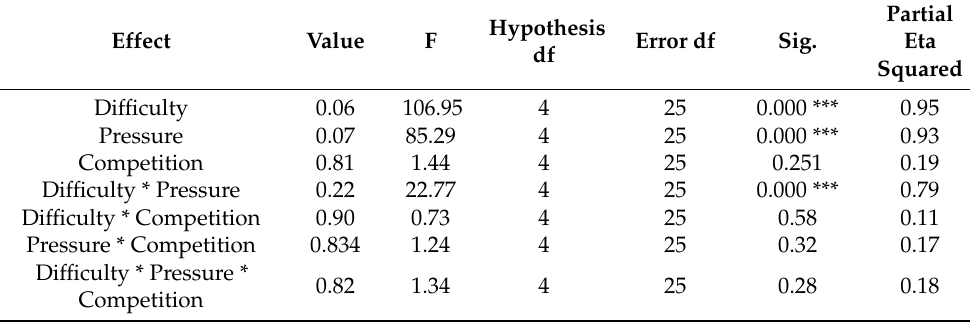
Table 23. Multivariate tests (Wilks’